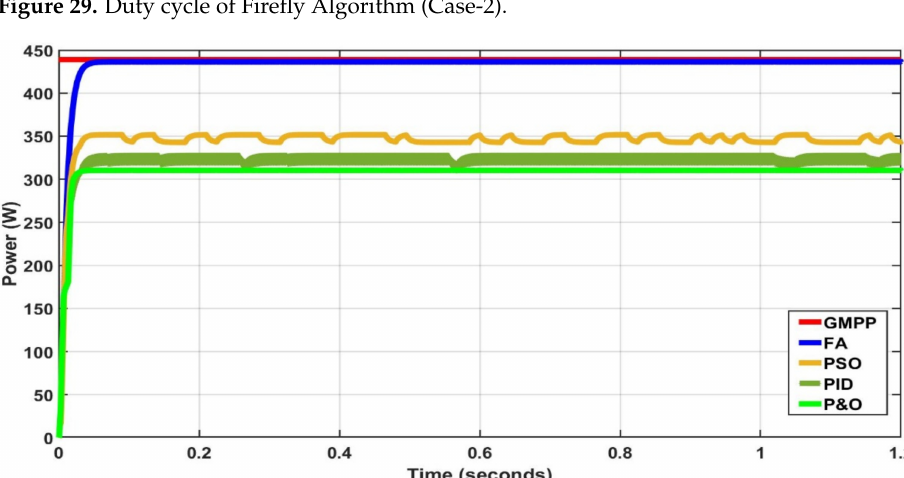
Figure 30. Comparison of FA with PSO, PID and P&O